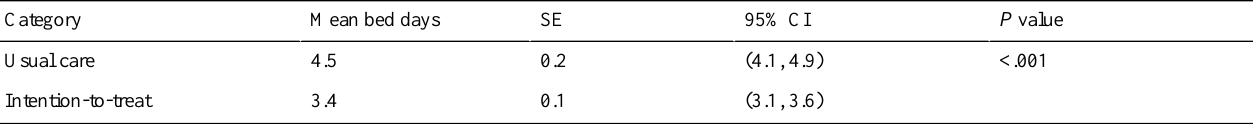
Table 4. ANCOVA least square mean bed days comparison for usual care versus intention-to-treat groups.